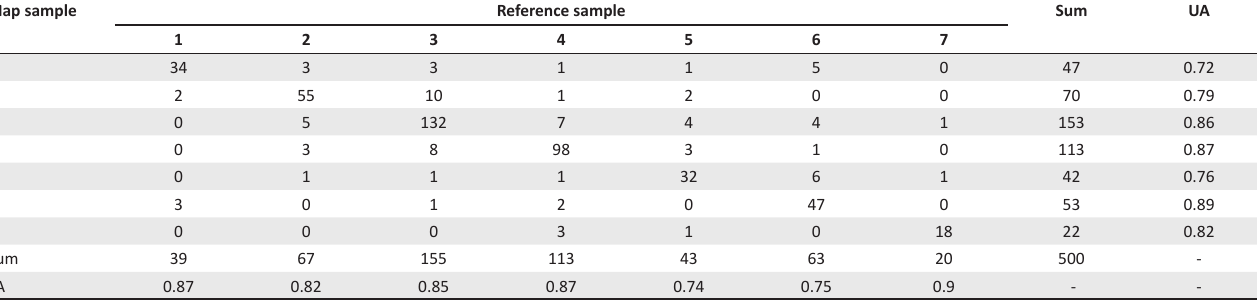
TABLE 1: Quantification of classification error using confusion matrix produced from 500 validation points obtained using a simple random sampling scheme. Map